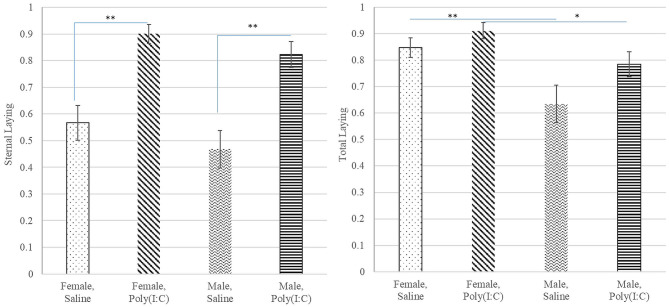
Probability of sternal (left) and total (right) laying behaviors (estimate and standard error of the mean) by Poly(I:C) treatment level (Saline or 1 mg/kg), and sex (Female or Male). **, *Difference between Poly(I:C)-sex groups significant at P-value < 0.005 and 0.05, respectively (n = 10).